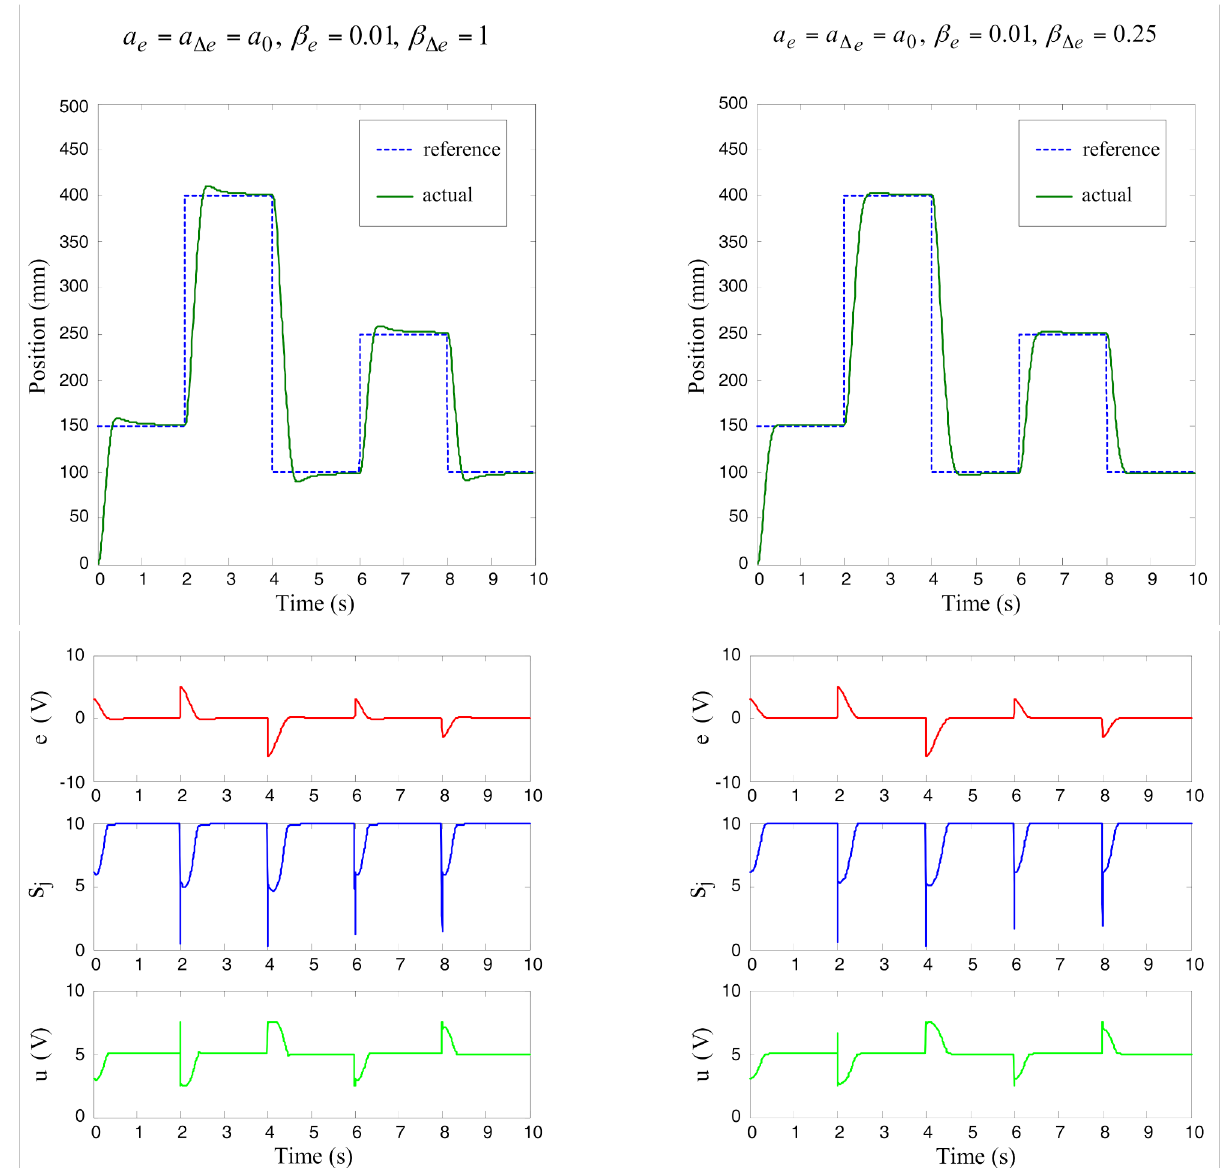
Figure 7. Simulation results for position control. Position error e and change of position error ∆ e are the input